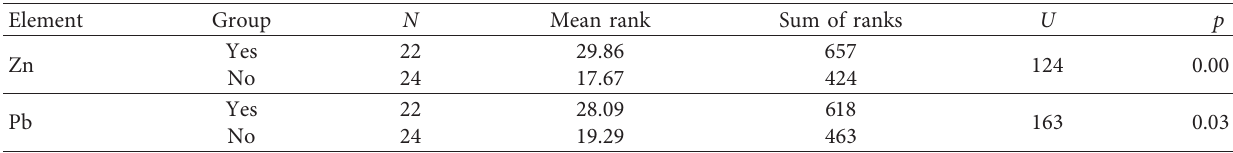
Figure 3: Heavy metal accumulation values of soil samples according to vegetation structure (mg/kg). Table 6: Mann–Whitney U test results of Zn and Pb contents.